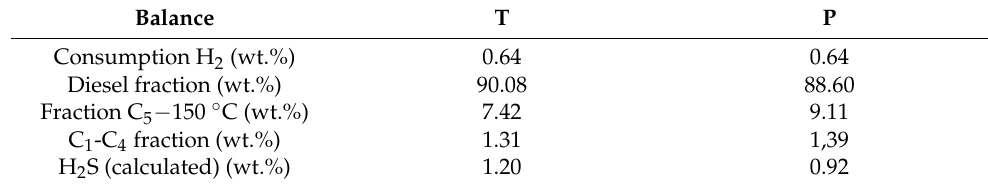
Table 6. Mass balances of the products during the processing of the pyrolysis oils. Balance Consumption H 2 (wt.%)